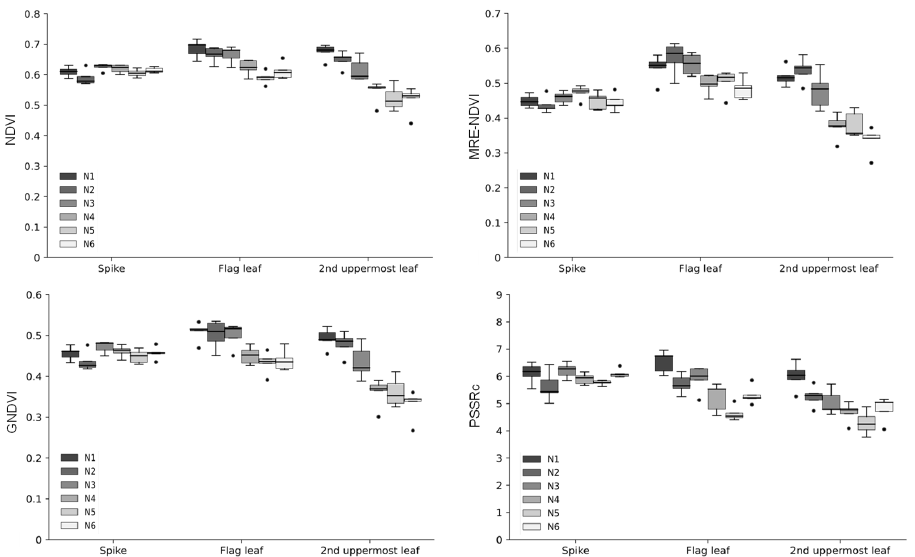
Figure 5. Variation of vegetation indices by the nitrogen levels. Vegetation indices were calculated with the spectral data of the base region in each organ. In the box plots, the bottom and top of the box describe the 25th and 75th percentiles, the band near the middle of the box is the 50th percentile (the median); the ends of the whiskers represent the minimum and maximum of the data. The black circle dots indicate outliers.